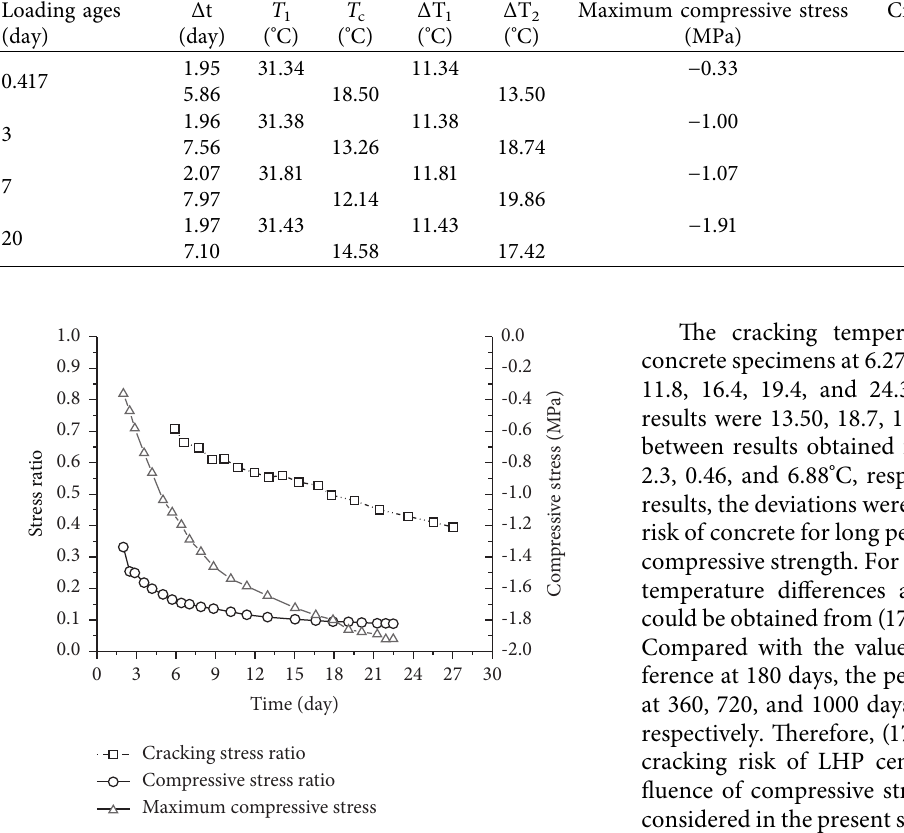
Figure 14: Cracking stress ratios at different